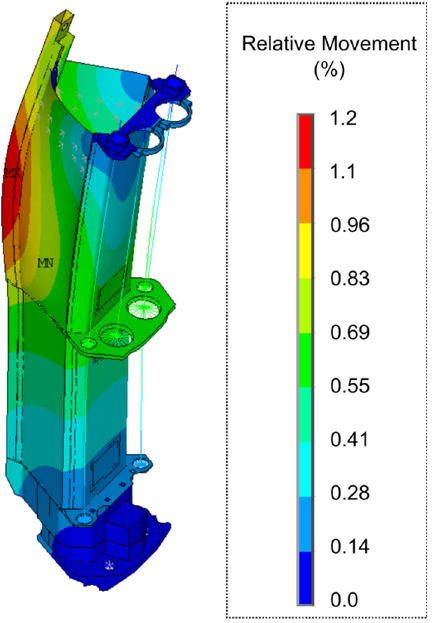
Fig. 14. Induced relative movement on P5 due to